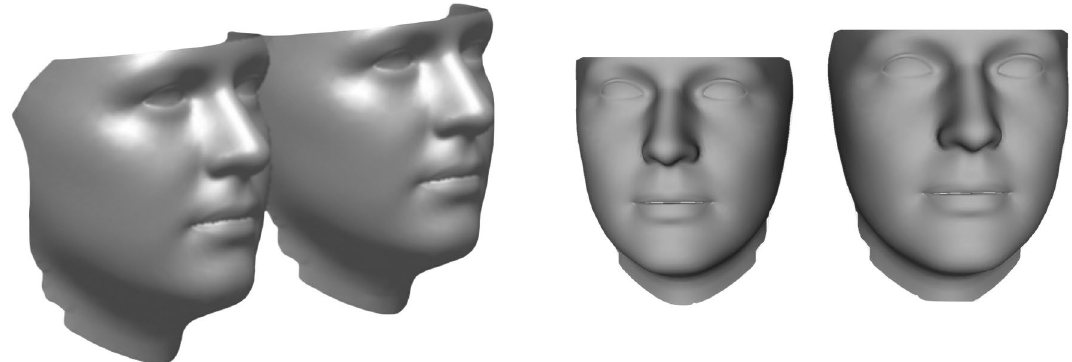
Figure 4. Sex-neutral face shape models in two sizes (small and large) calculated using the R Software (R Core Team, R: A Language and Environment for Statistical Computing, R Foundation for Statistical Computing, Vienna, Austria, 2020, https:// www.R- proje ct. org).